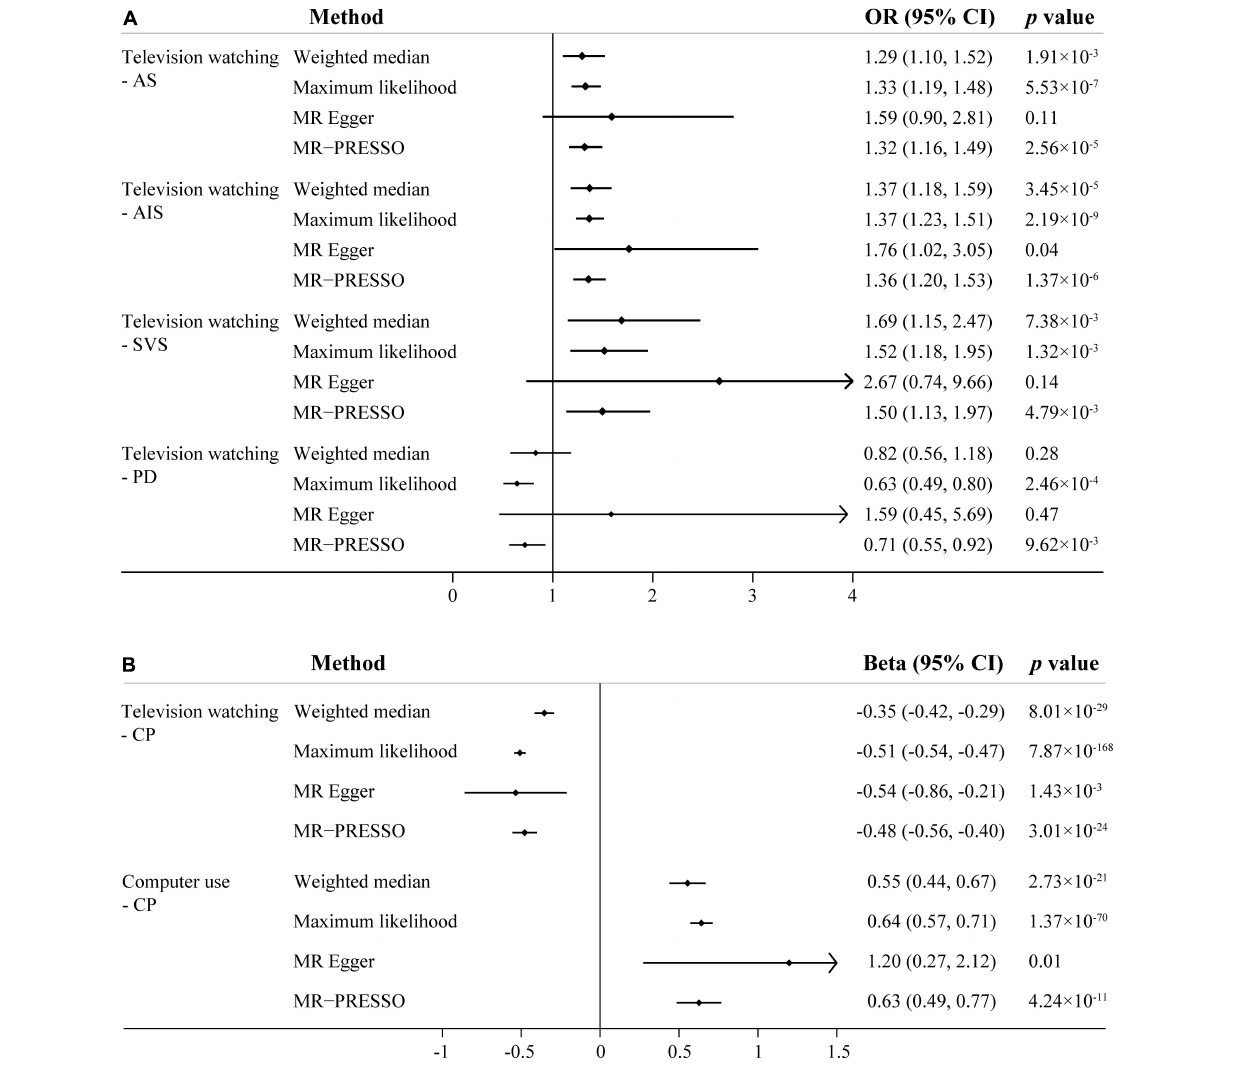
FIGURE 2 | Sensitivity analysis of sedentary behaviors with stroke, Parkinson’s disease and cognitive performance using different Mendelian randomization statistical models. (A) The effect of television watching on all-cause stroke (AS), any ischemic stroke (AIS) and Parkinson’s disease (PD); (B) The effect of television watching and computer use on cognitive performance (CP). OR, odds ratio; CI, confidence